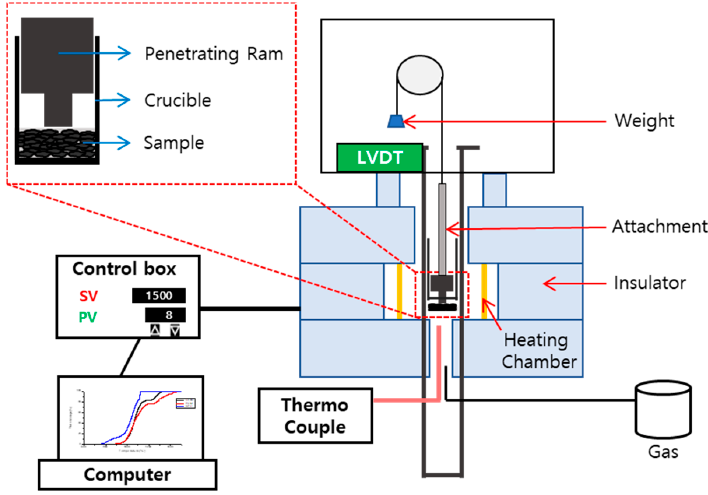
Figure 1. Schematic diagram of the thermomechanical analysis (TMA) device.